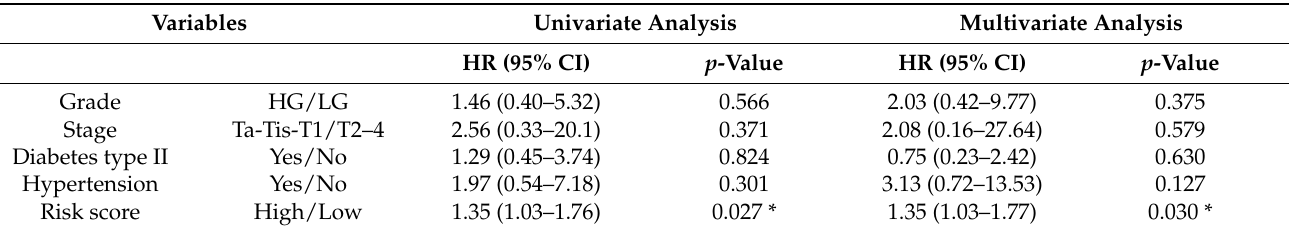
Figure 6. The development of the four-mRNA-based prognostic model. ( A ) The Kaplan–Meier analysis for RFS by stratifying patients into high- and low-expressing for the EGFR, TRPM4, TWIST1, and ZEB1 levels. ( B ) The Kaplan–Meier and ( C ) ROC curve analysis for RFS by stratifying patients into the high- and low-risk score according to the four-mRNA-based signature. ( D ) The representative images of CTCs stained with anti-human EGFR, TRPM4, TWIST1, and ZEB1 Abs followed by Alexa 594-conjugated secondary Ab. DAPI was used to counteract the nuclei. Magnification 60×. Table 4. The univariate and multivariate analysis of the risk score, grade, stage, diabetes type II, hypertension, and 3.5. The Risk Score Based on Four-mRNA Signature Predicted the RFS of BC Patients: Valida-